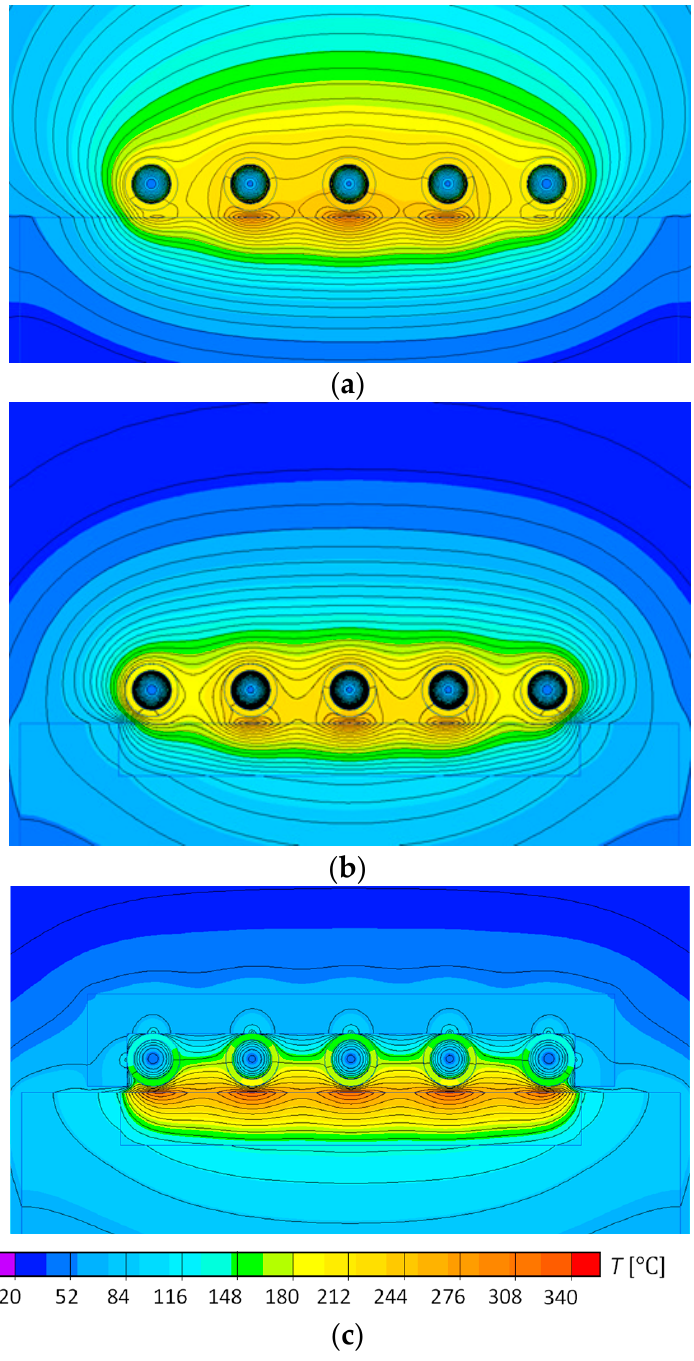
Figure 4. The temperature inside the block distribution after 10 s of heating for geometries ( a ) P1, ( b ) P2, and ( c ) P3.